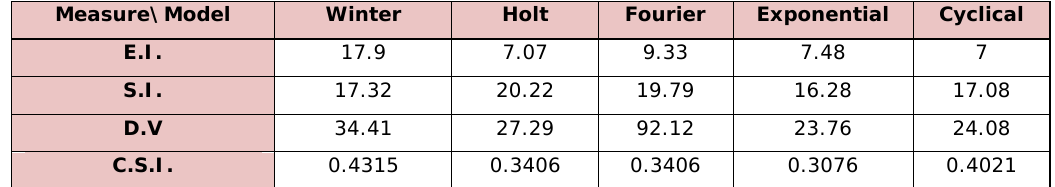
Table 2. “Comparative statistics of inventory and CSI for year 2006-07”